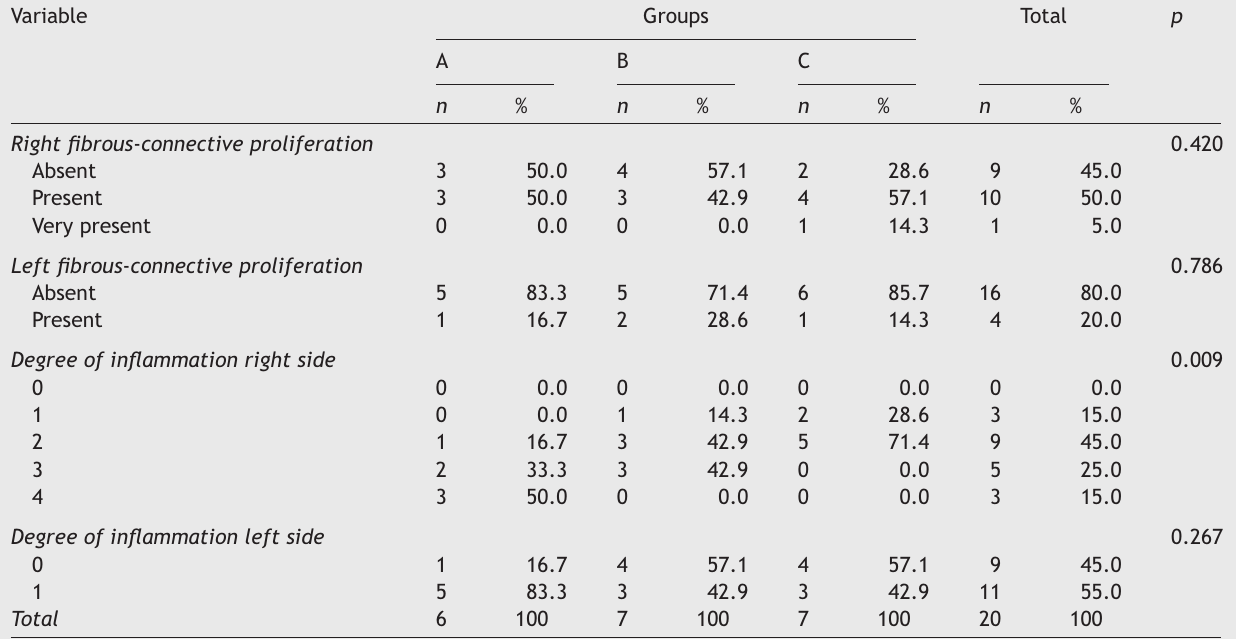
Description of the degree of inflammation and fibrous-connective proliferation according to the day of euthanization of the groups and statistical test results.